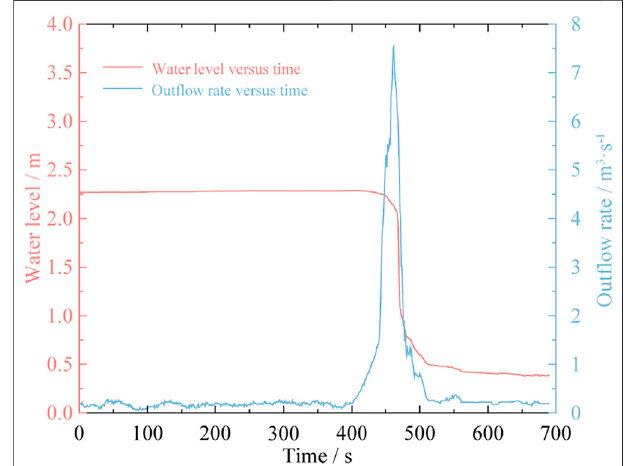
FIGURE 10 | Failure time of each